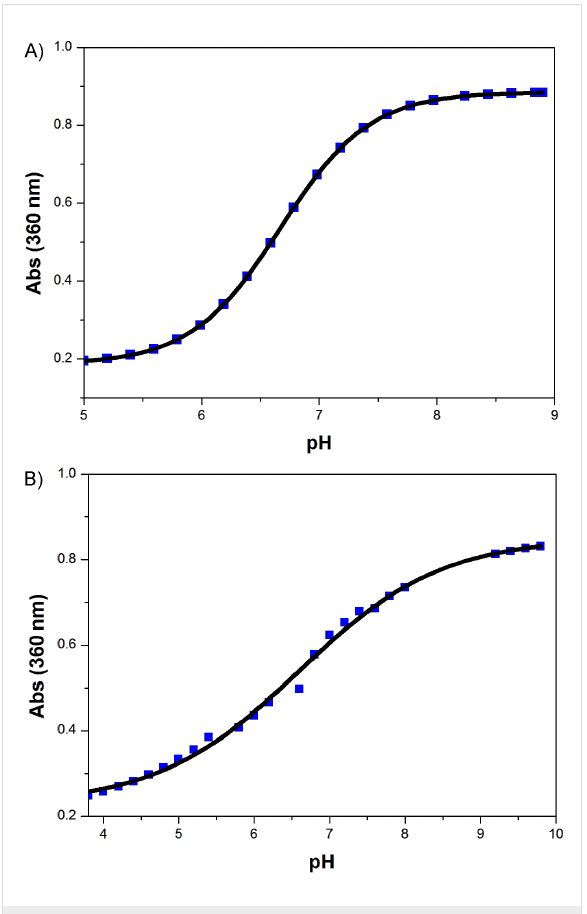
Figure 3: Absorbance of compounds 1b and 1c at 360 nm as a func- tion of pH value. (A) Absorption spectrum of 50 μ M compound 1b in 200 mM sodium phosphate buffer (pH 5.8–8.0), 200 mM sodium acetate buffer (pH 3.7–5.6) or 50 mM Tris-HCl buffer (pH 8.2–8.9). (B) Absorption spectrum of 25 μ M compound 1c in 200 mM sodium phos- phate buffer (pH 5.8–8.0) or sodium acetate buffer (pH